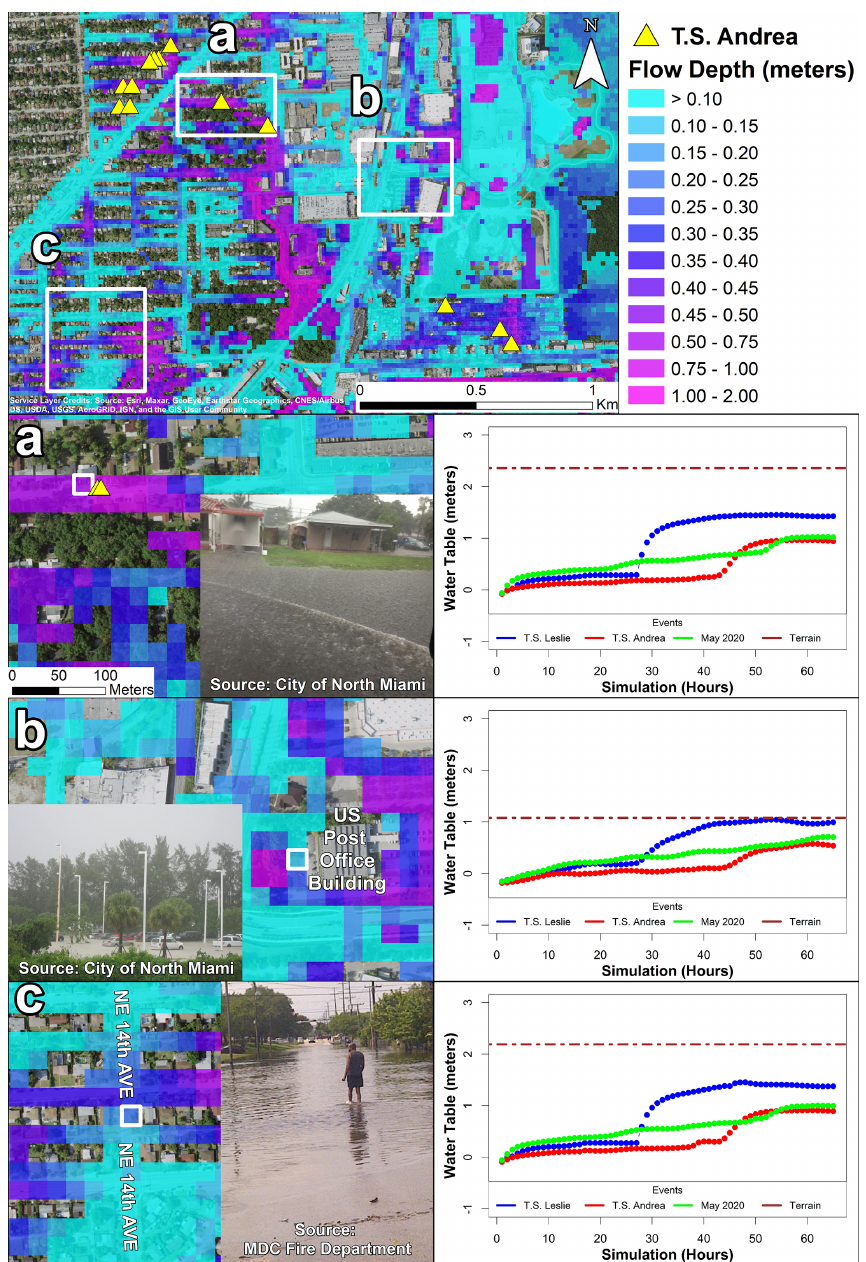
Figure 13. Maximum flood depths for Tropical Storm Andrea in the northwestern portion of the Arch Creek Basin (top panel). The markers (yellow) display properties that were affected during Tropical Storm Andrea. Three sample locations (white) are presented as subdomains (a– c) , and available crowdsourced observations display the flooding conditions at a specific cell (white). The simulated water table time series (right panel) show that groundwater heads remained below the surface elevation (brown line); thus, all three locations experienced rainfall- induced